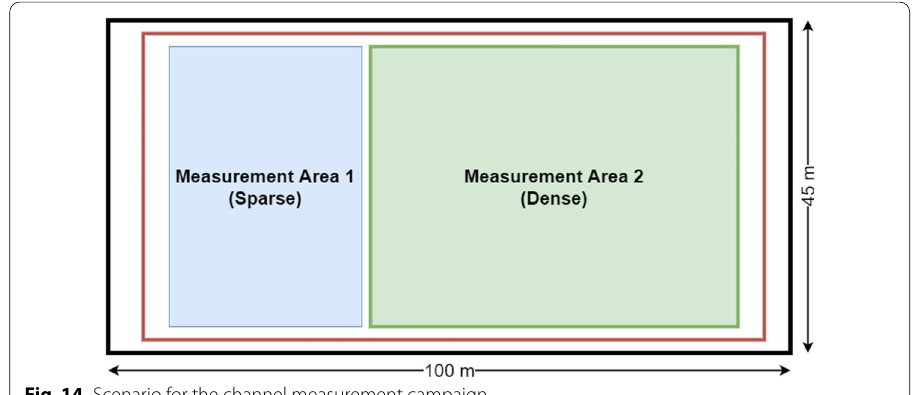
Fig. 14 Scenario for the channel measurement